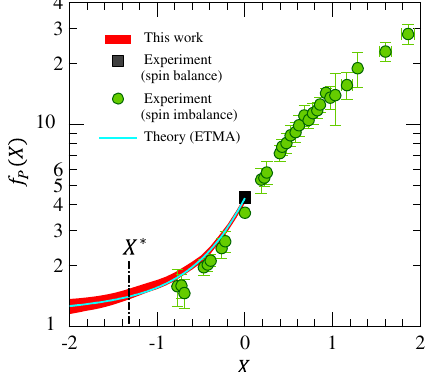
FIG. 7. Experimental and theoretical dimensionless pressure. The vertical axis follows a logarithmic scale. The red curve indicates the experimental data of the present study. The width indicates the total systematic error. The green circles and the black square indicate the experimental values obtained using spin imbalanced Fermi gases [18] and spin balanced unitary Fermi gas [19], respectively. The light blue curve indicates the theoretical calculation of the ETMA [31,32]. The vertical dash-dotted line indicates the superfluid transition point X (cid:4) of the present study.